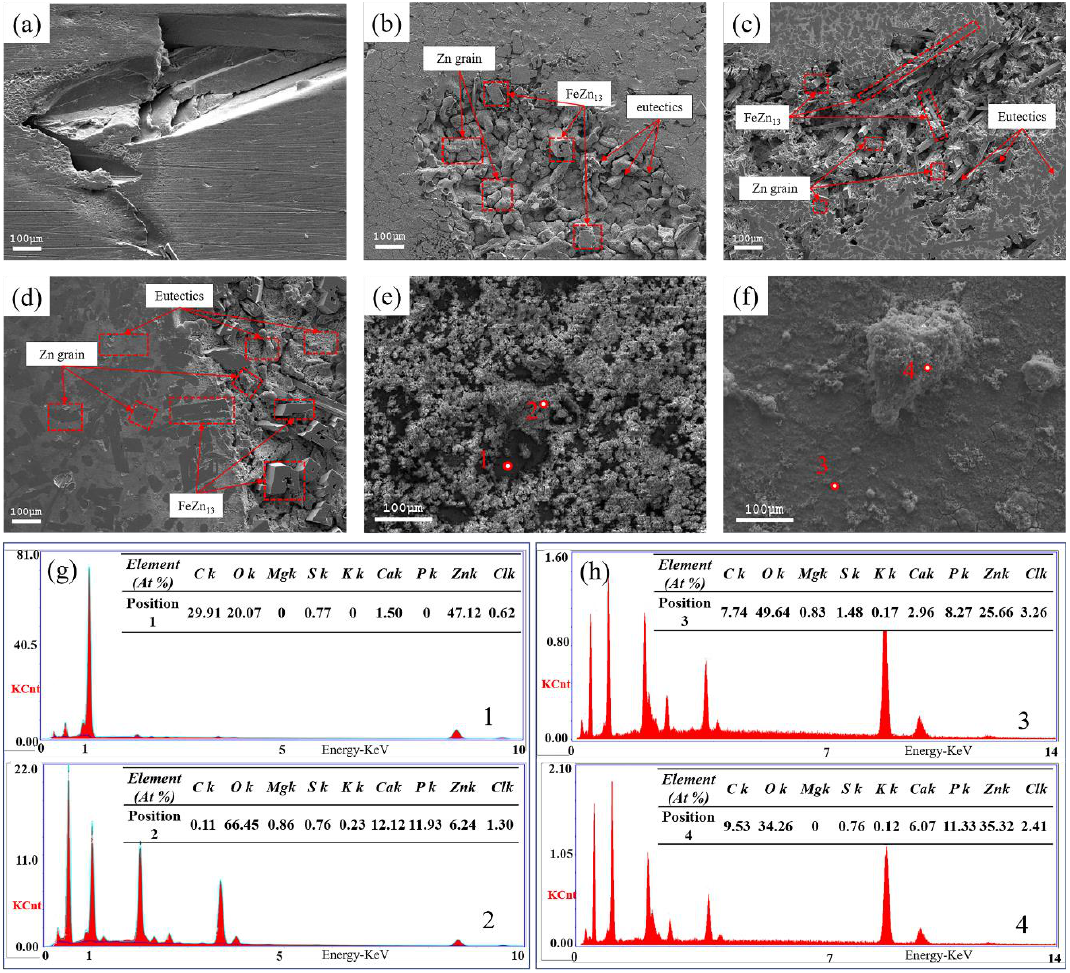
Figure 8. SEM micrographs of surface morphologies of ( a ) pure Zn, ( b ) Zn1Fe0.5Mg, ( c ) Zn1Fe1Mg, and ( d ) Zn1Fe1.5Mg alloys with the removal of surface corrosion products after immersion in SBF solution for 30 days; ( e , f ) surface morphologies of Zn1FeMg immersed in SBF for 30 days and 60 days, respectively; ( g , h ) EDS result corresponding to the area in ( e , f ), respectively.